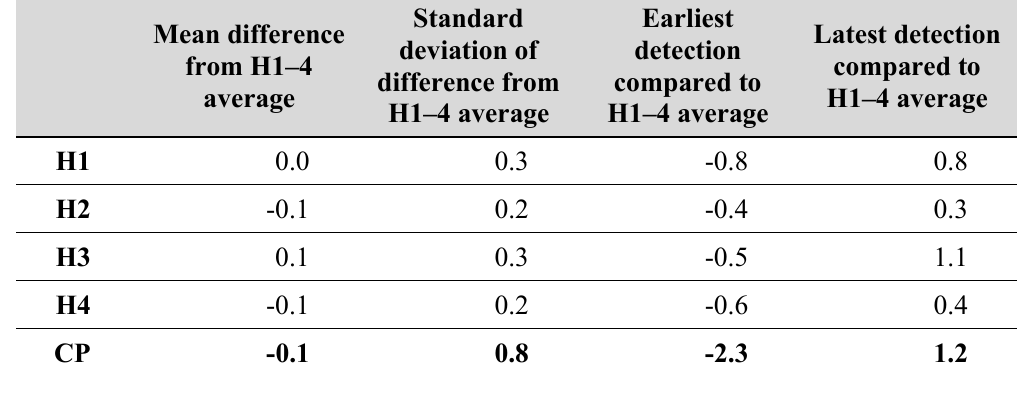
Table 2 Performance of the individual observers and the computer algorithm, compared to the human observers’ average (validation, Spanish site, all values in